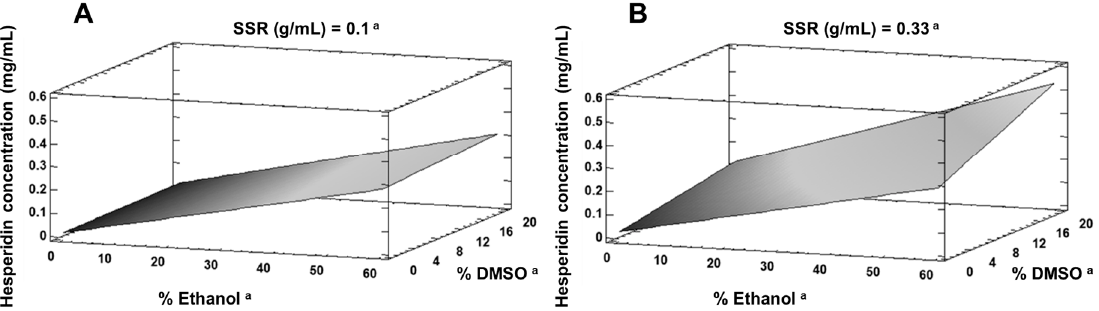
Figure 2. Concentration of hesperidin in the extract for a solid-to-solvent ratio (SSR) of 0.1 g/mL ( A ) and 0.33 g/mL ( B ). a Significant factors in the variance analysis ( p < 0.05).